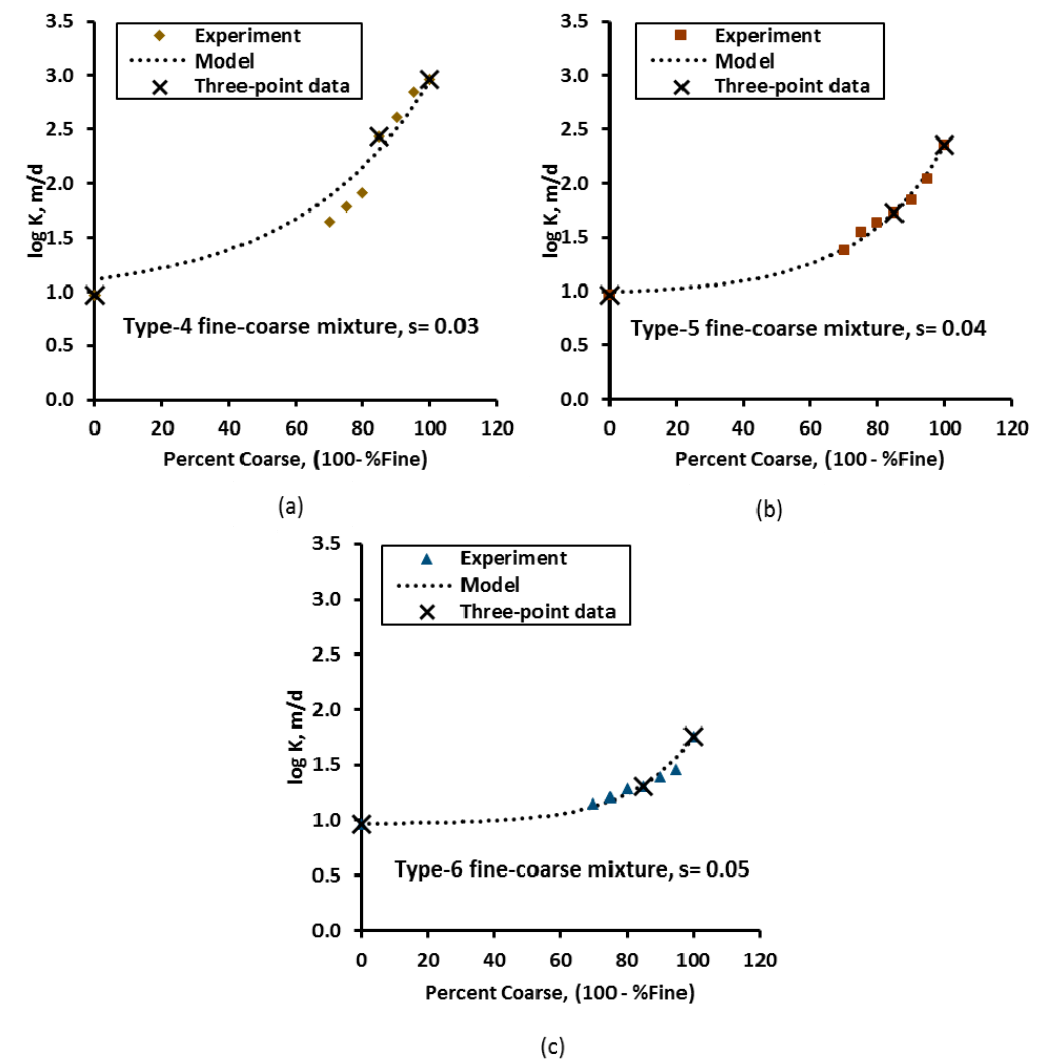
Figure 5. Comparison of fitted model results with experimental data for all three types of fine-coarse mixtures: ( a ) Type-4 (K c = 920 m/day and K f = 9 m/day), ( b ) Type-5 (K c = 228 m/day and K f = 9 m/day), and ( c ) Type-6 (K c = 57 m/day and K f = 9 m/day). The cross symbol is used to identify the data points used in the three-point method discussed in Section 3.5.